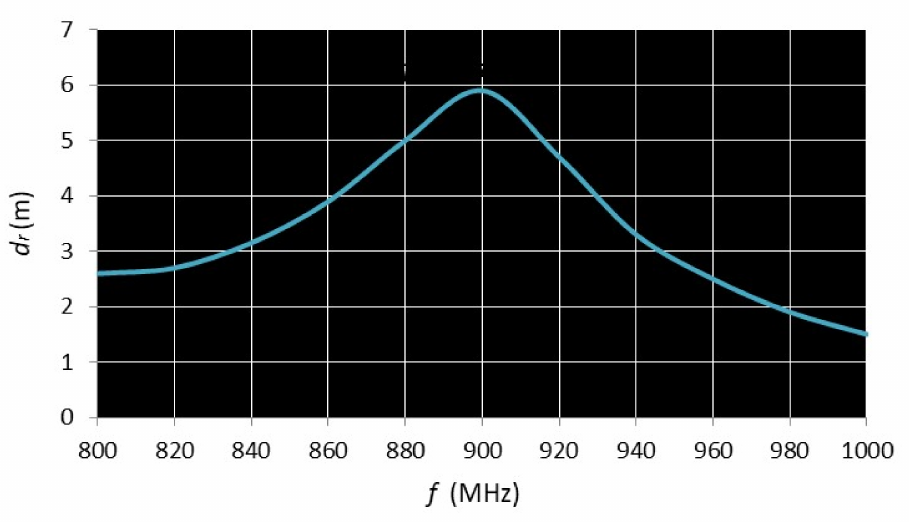
Figure 11. The read range d r as a function of frequency for V5 (Dac100) tag.